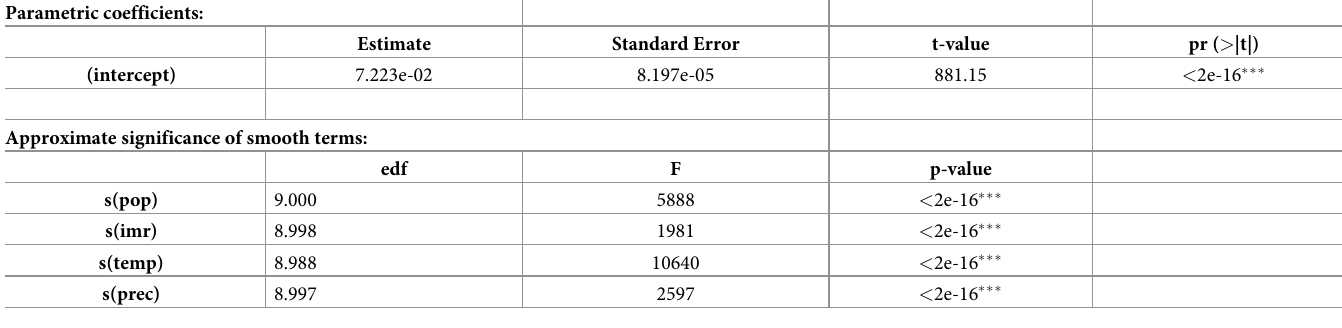
Table 4. Results of Generalized Additive Model (GAM) for Model 3. Family: gaussian; link function: identity. (Formula: amd_r ~ s(pop_r) + s(imr_r) + s(temp_r) + s (prec_r); n = 1,190,702). Parametric